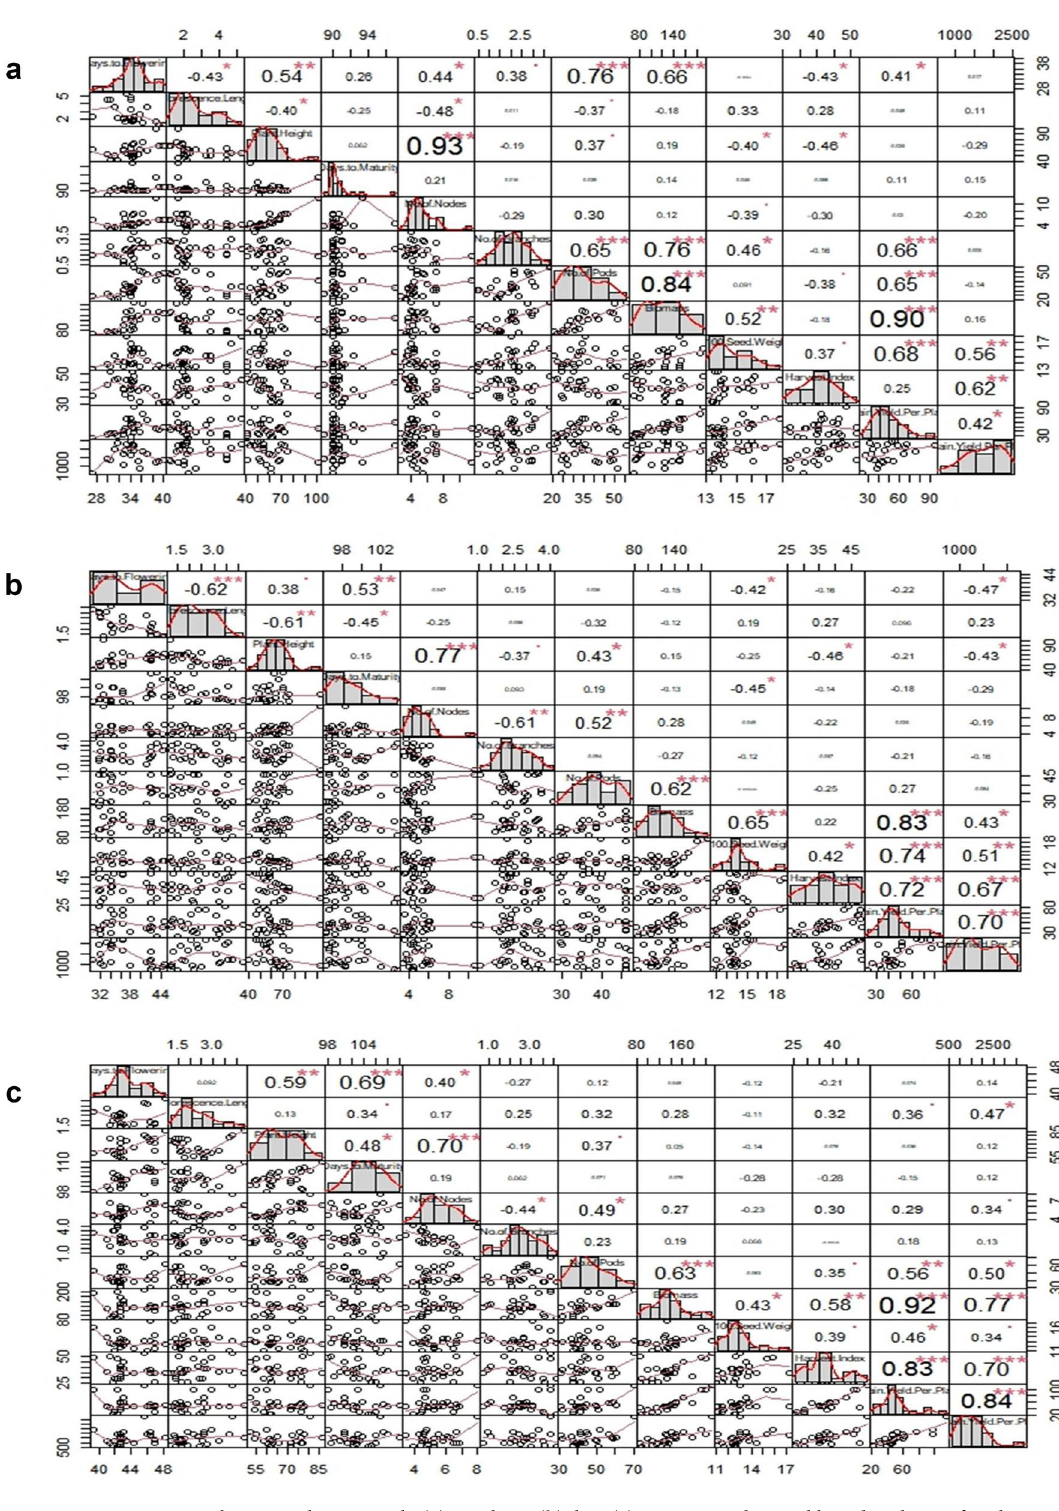
Figure 3. Correlation analysis in early ( a ), medium ( b ), late ( c ) maturing advanced breeding lines of soybean. (Generated using R package “PerformanceAnalytics version 2.0.4 URL https:// github. com/ brave rock/ Perfo rmanc eAnal